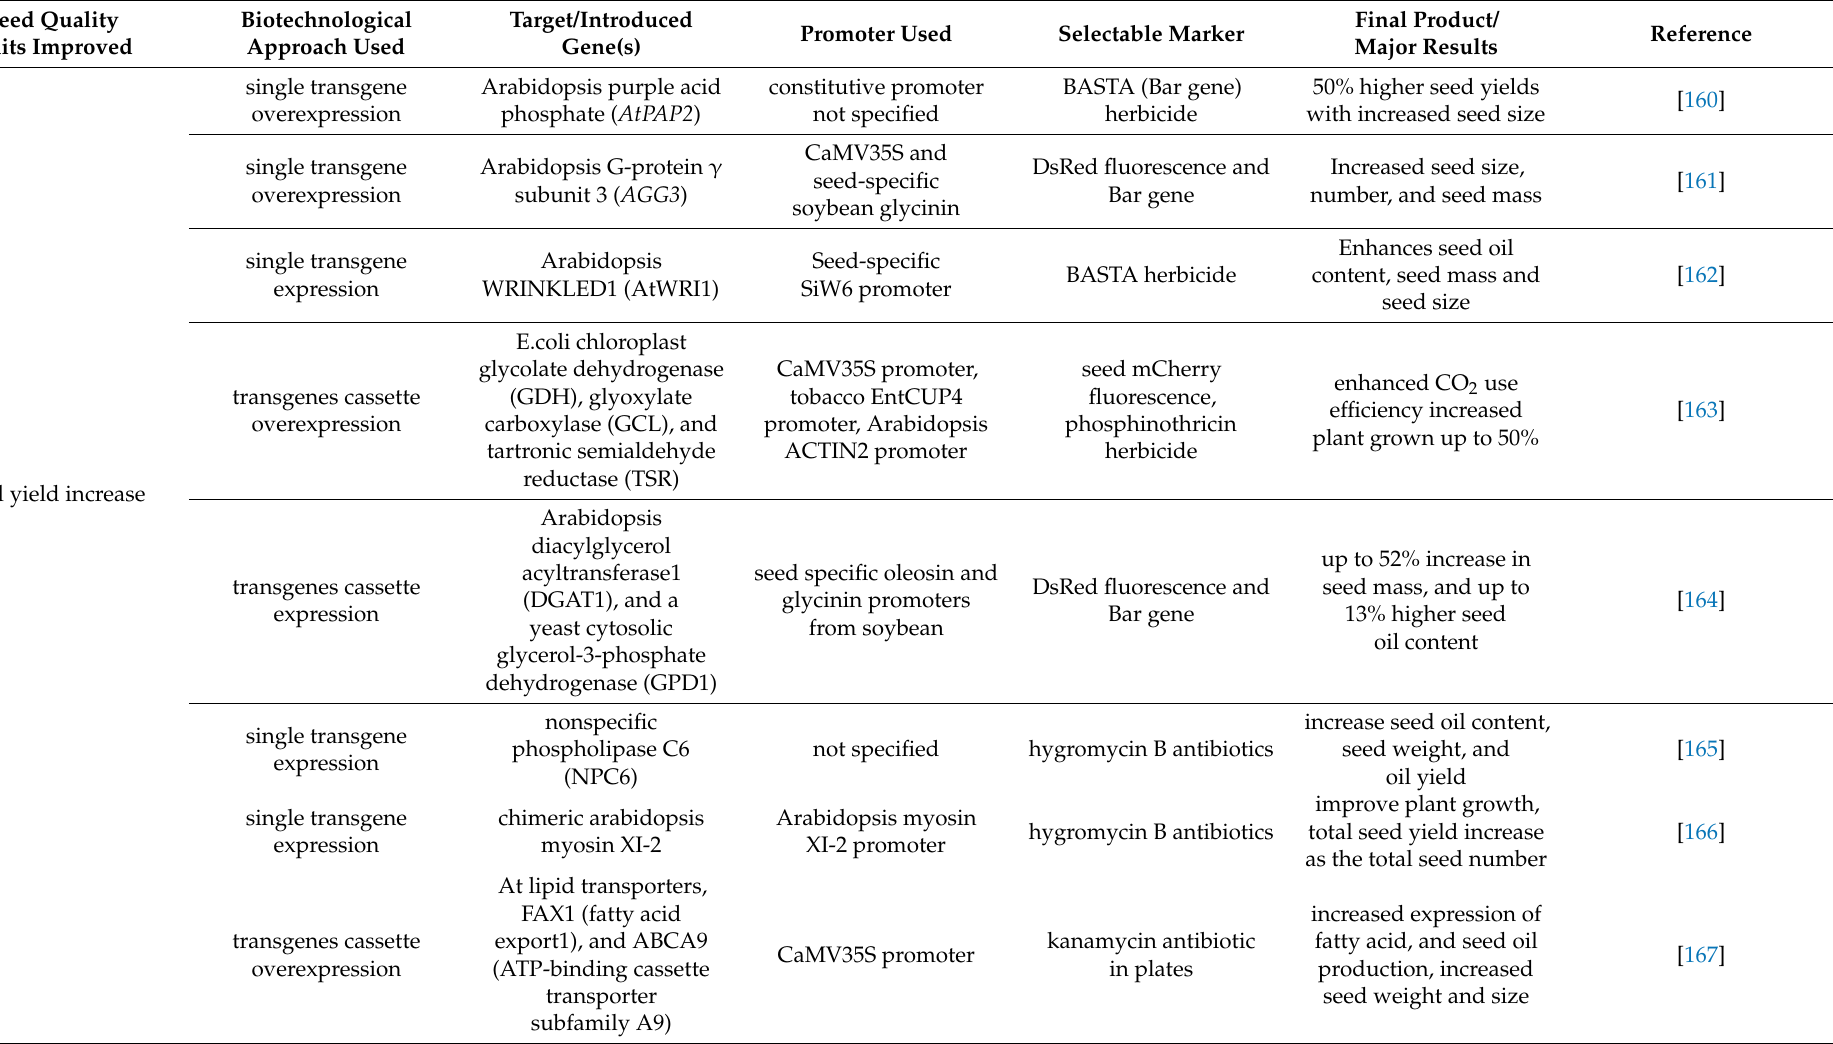
Table 2. Select examples of camelina seed improvement performed by engineering